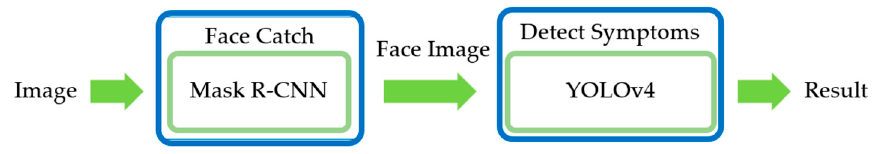
Figure 4. The structure of detection symptoms.